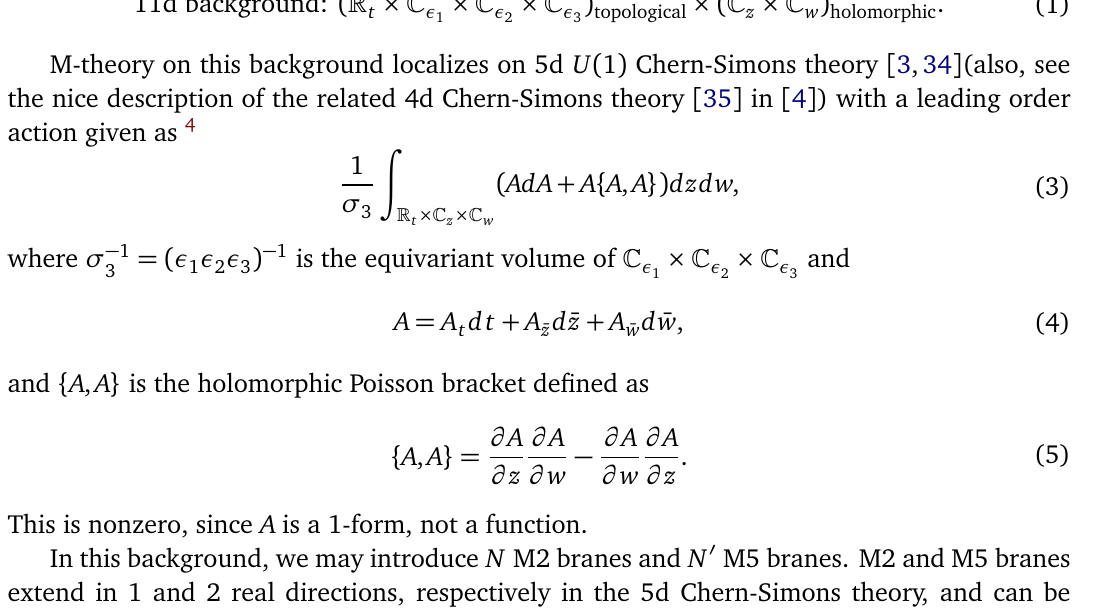
Table 1: M2, M5-brane and 5d Chern-Simons theory. In general, M 2 branes may extend over (cid:82) i , j ∈ { 1,2,3 }